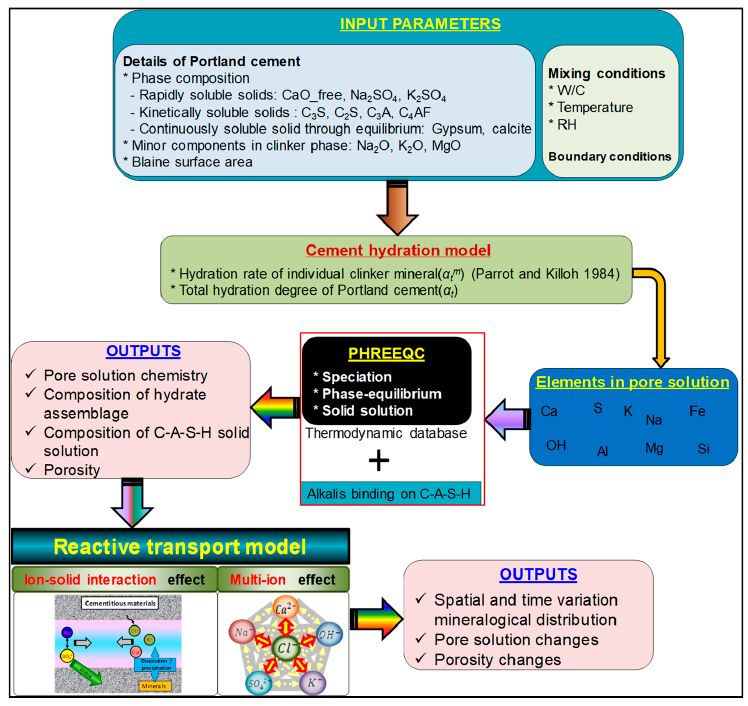
Figure 1. Schematic diagram for the calculation procedure. Table 1. Chemical composition and physical properties of PC and mixing conditions.